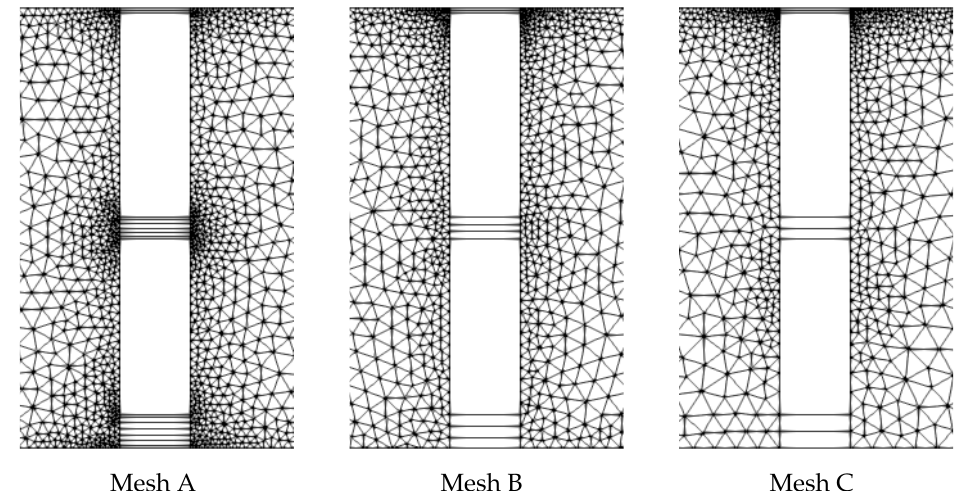
Figure 12. Computational meshes around orifices for one-dimensional orifice element model simula- tions of violent slosh test